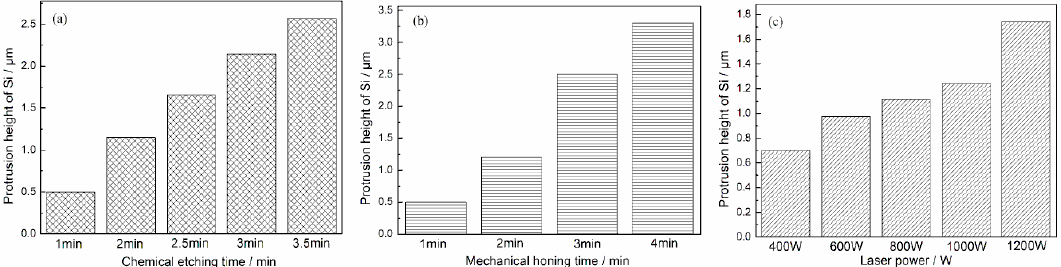
Figure 10. Protrusion height of silicon particle after different treatment: ( a ) Chemical etching; ( b ) mechanical honing; ( c ) laser finishing.